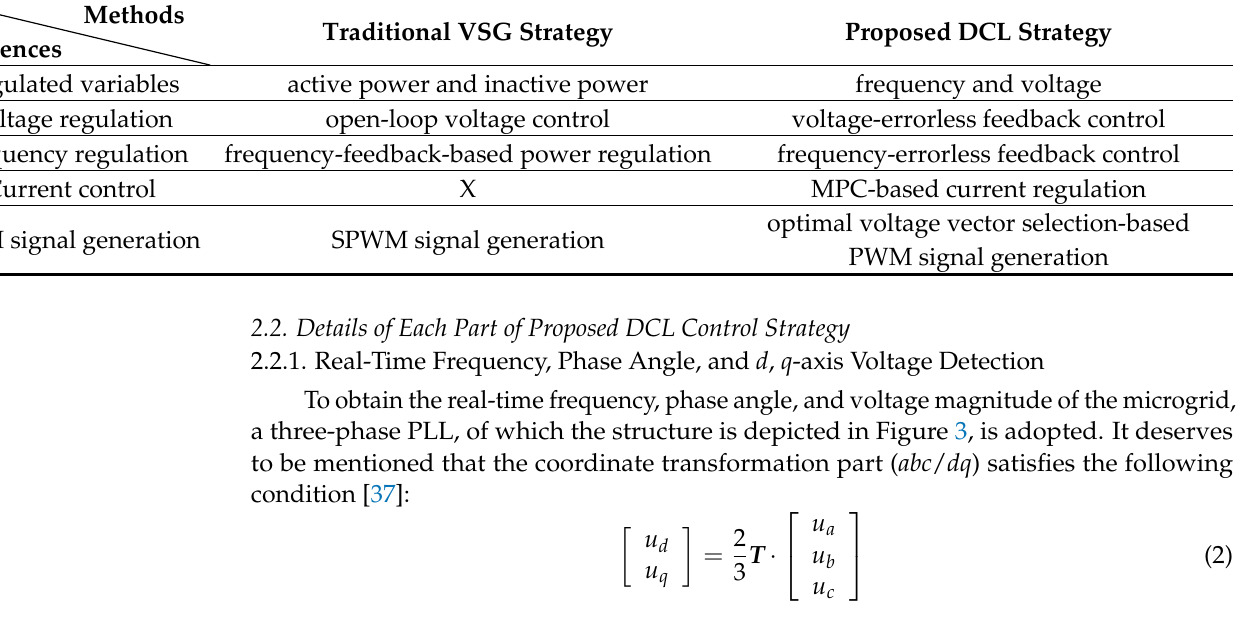
Table 1. Comparisons of traditional VSG strategy and proposed DCL strategy.